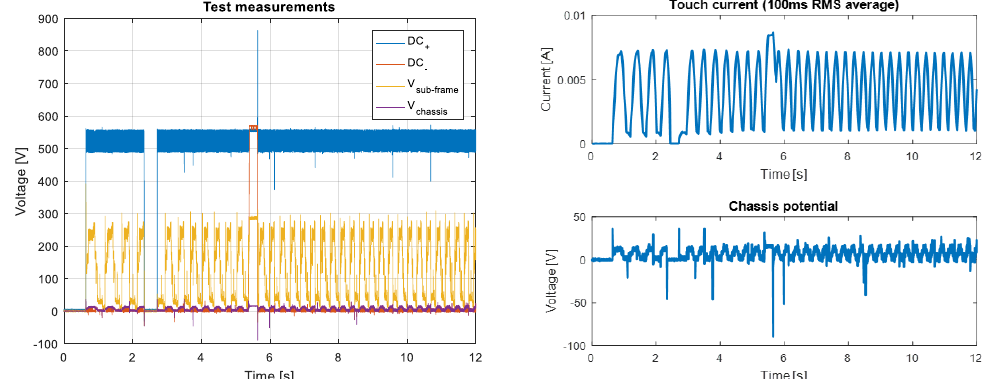
Figure 8. Real pick-up installation on a test vehicle ( left ) and concept drawing identifying the main components ( right ).